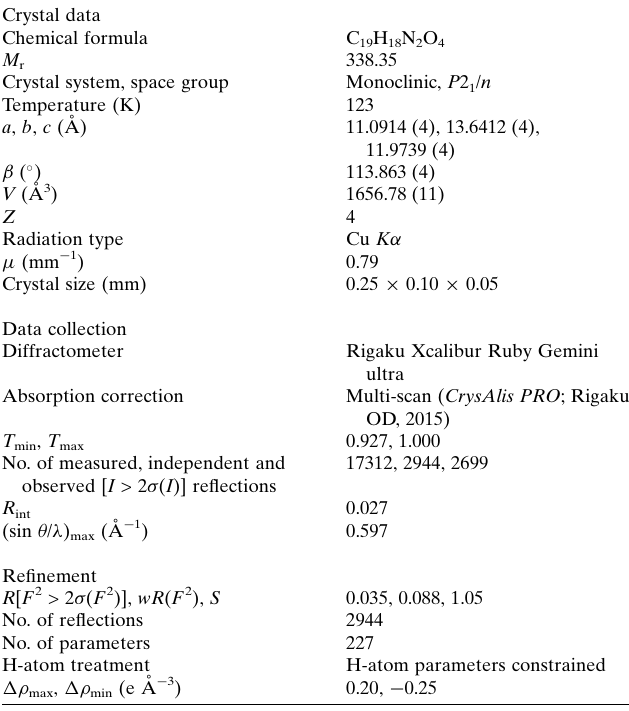
Table 2 Experimental details. Crystal data Chemical